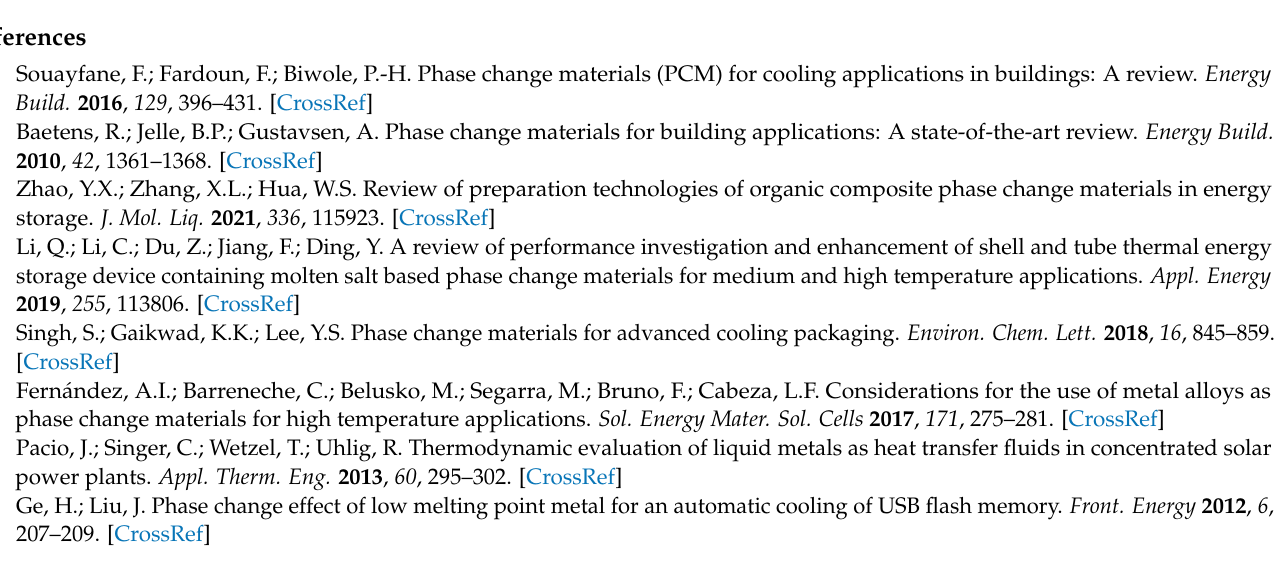
Figure S3: DSC curves of SnCu 0.02 @SiO 2 and SnCu 0.03 @SiO 2